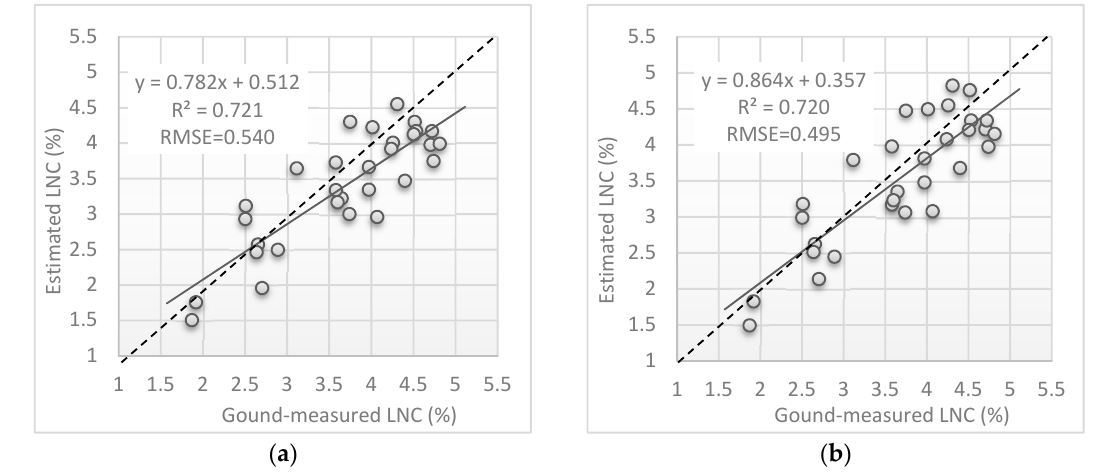
Figure 7. Ground-measured nitrogen content versus the estimated values from the inversion model: ( a ) estimated by FD-NDNI and ( b ) estimated by FD-SRNI.